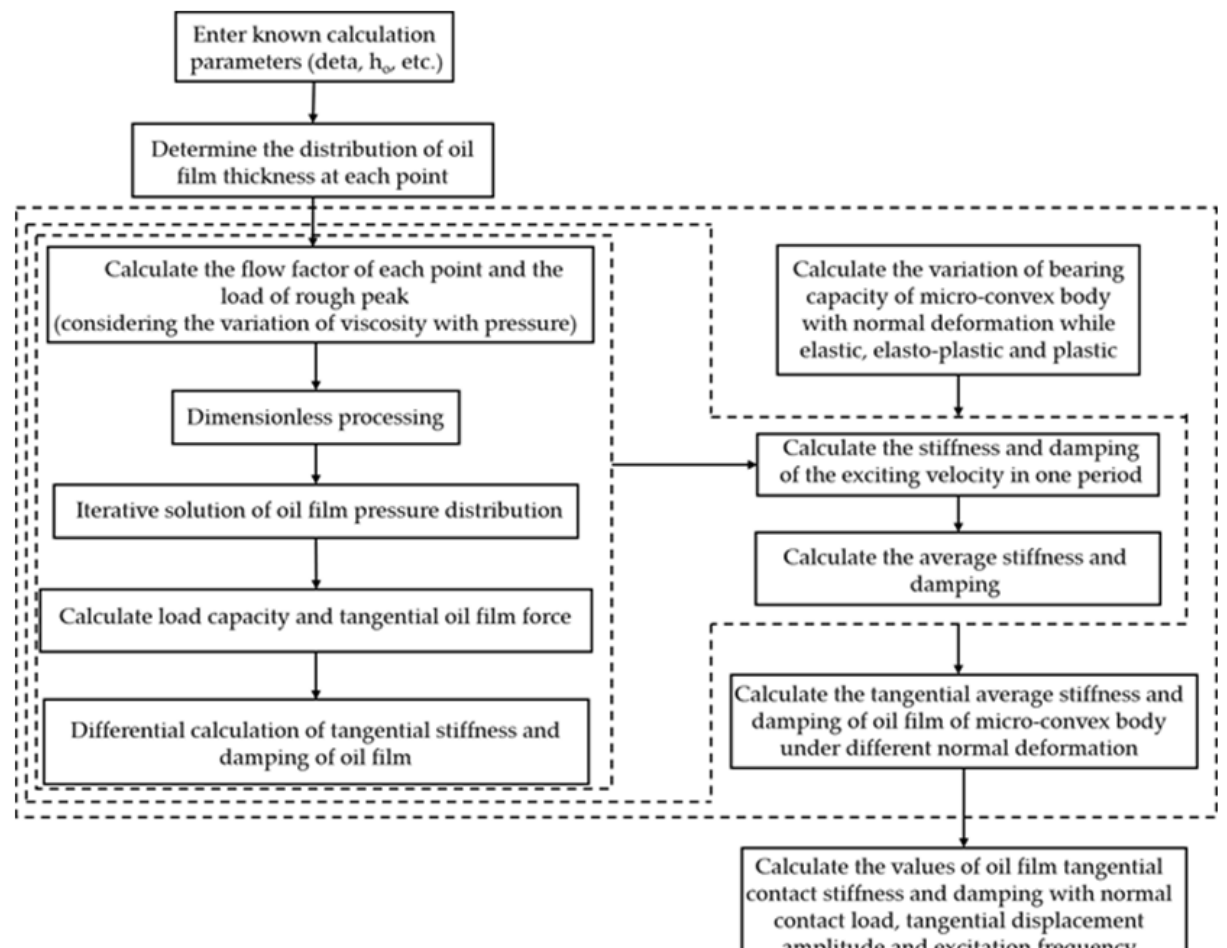
Figure 1. Calculation process of tangential stiffness and damping of the fluid part of the solid– liquid